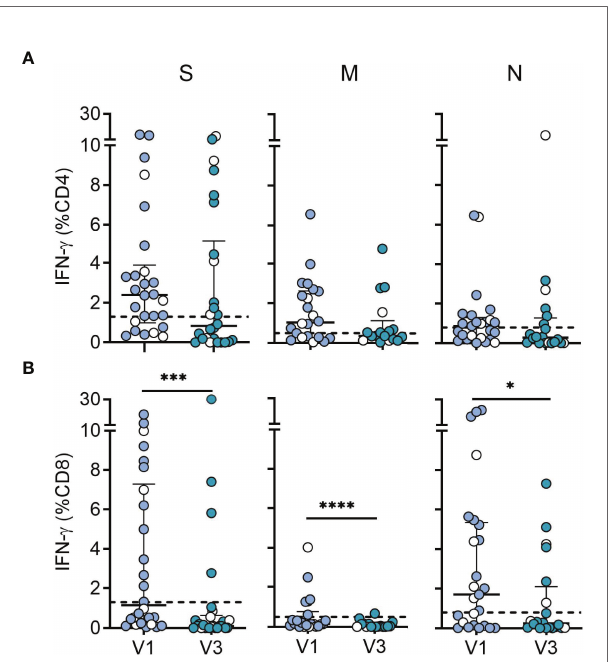
FIGURE 2 | Durability of SARS-CoV-2 speci fi c CD4 and CD8 T cell responses. (A) CD4 T cell responses and (B) CD8 T cell responses from SARS-CoV-2-seropositive children (n = 26) measured 6 (V1; n = 26) and 12 months (V3; n = 20) after serodiagnosis. Plots show IFN- g expression levels in response to peptide pools covering the entire sequences of wildtype SARS- CoV-2 spike (S), membrane (M) and nucleocapsid (N) proteins. PBMCs were cultured with spike, membrane and nucleocapsid peptides for 10 days followed by restimulation with the same antigens and analysis of IFN- g using fl ow cytometry intracellular cytokine staining. Bars represent median ± IQR. Blue symbols, symptomatic infection; white symbols, asymptomatic infection. The dashed line represents the cut-off for assay positivity. Paired groups were compared with the two sided Wilcoxon signed rank tests (*P < 0.05; ***P < 0.001; ****P <